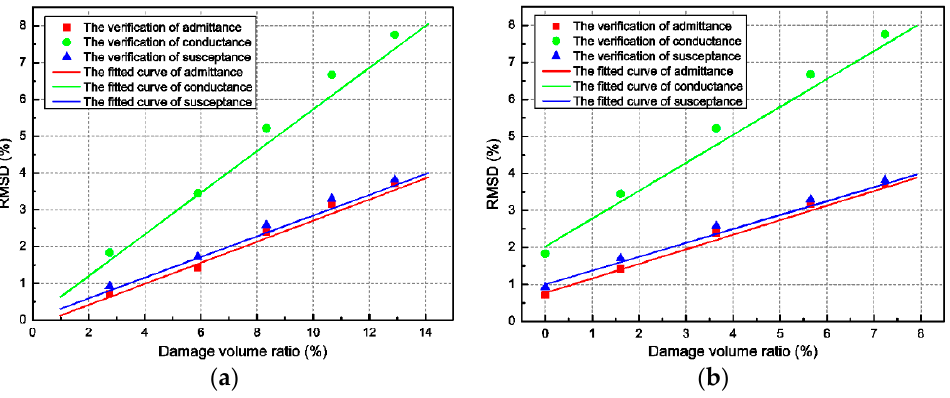
Figure 10. Verification of the fitted curves: ( a ) global damage ( d > 0); and ( b ) local damage ( d > 0.7).